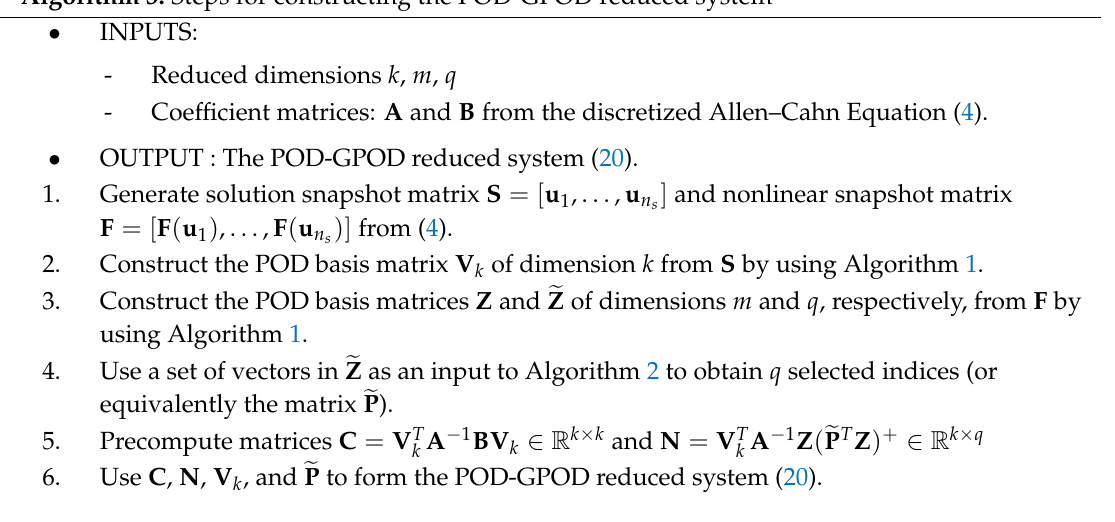
Algorithm 3: Steps for constructing the POD-GPOD reduced